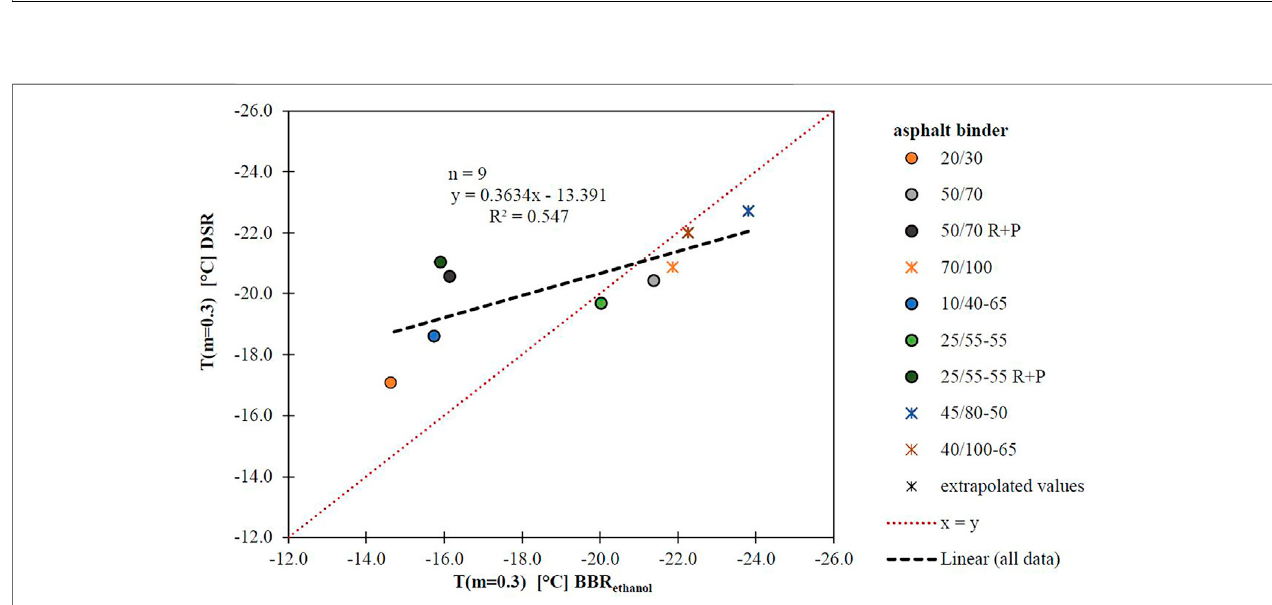
FIGURE 13 | Correlating characteristic temperatures T ( m = 0.3) obtained from BBR tests and DSR tests.